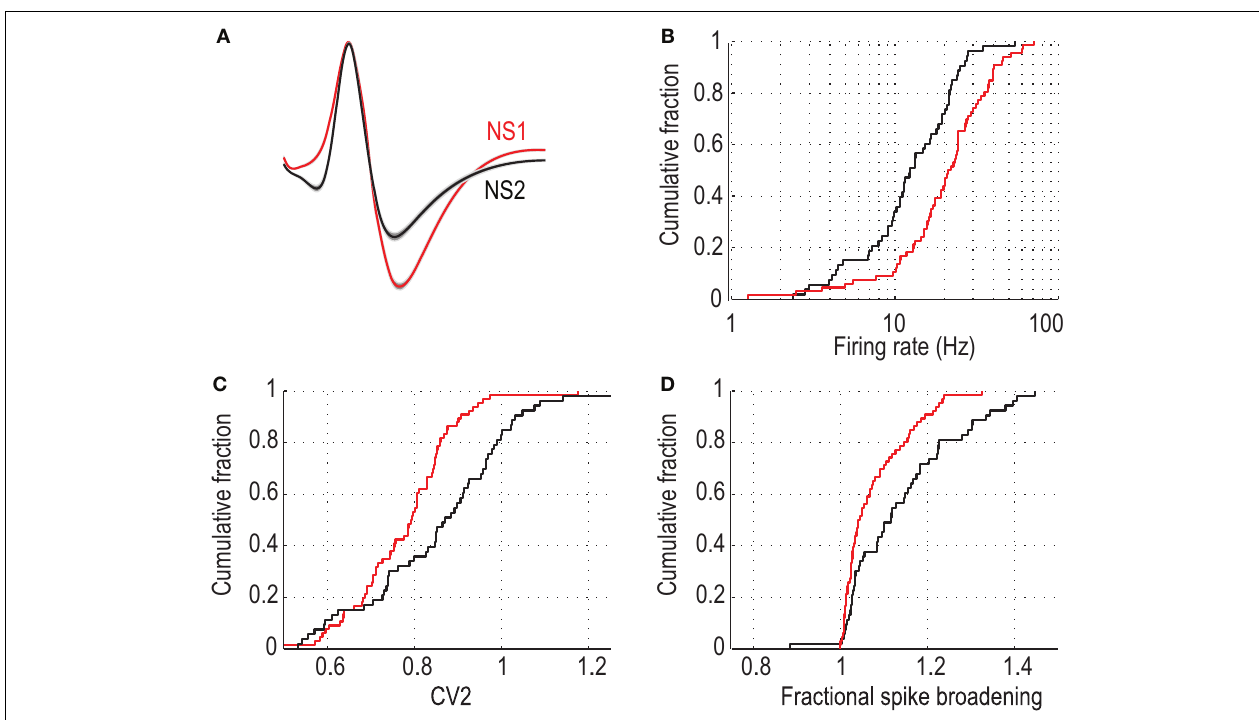
FIGURE 3 | Physiological distinct properties for two populations of narrow-spiking neurons. (A) Average peak-normalized waveforms for NS1 (red) and NS2 (black) cell classes (upward defl ections indicate depolarization). Cumulative distributions of activity dependent properties for NS1 (red) and NS2 (black) neurons. (B) Log fi ring rate, (C) CV2, (D) fractional spike broadening